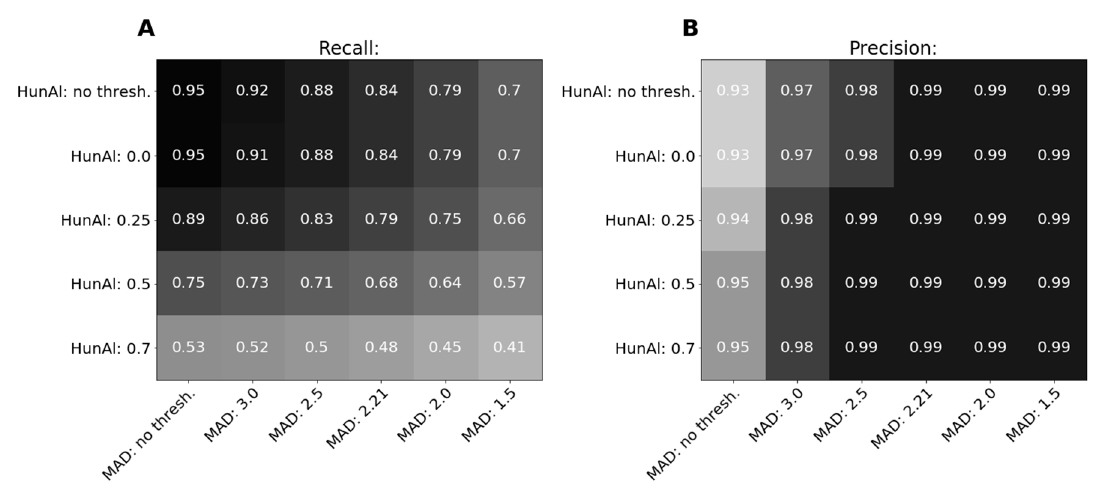
Figure A2. Evaluation on gold standard (EN–FR) for various Hunalign and MAD thresholds. The first row shows results when no threshold is set for Hunalign, and the first column shows results when no threshold is set for MAD. ( A ) Recall. ( B ) Precision.